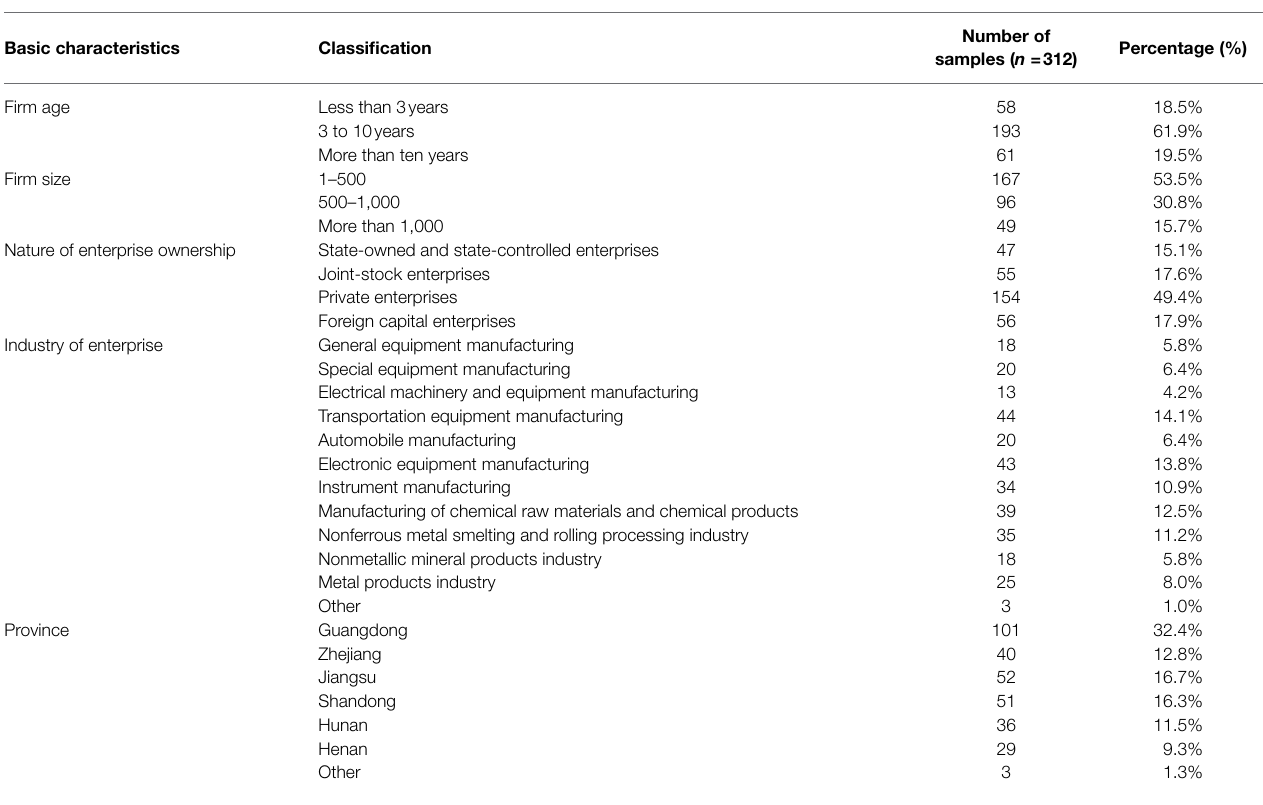
TABLE 1 | Detailed information of subjects collected in this